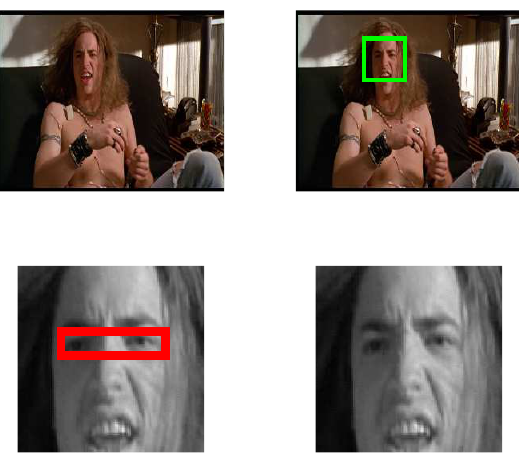
Figure 2. Examples of image pre-processing based on the algorithm of cropping face region: the top-left corner is the original facial expression image; the bottom left is the image of eye orientation; the top-right corner is the image of face positioning based on eye orientation; and the last one is the face region that used in experiments.